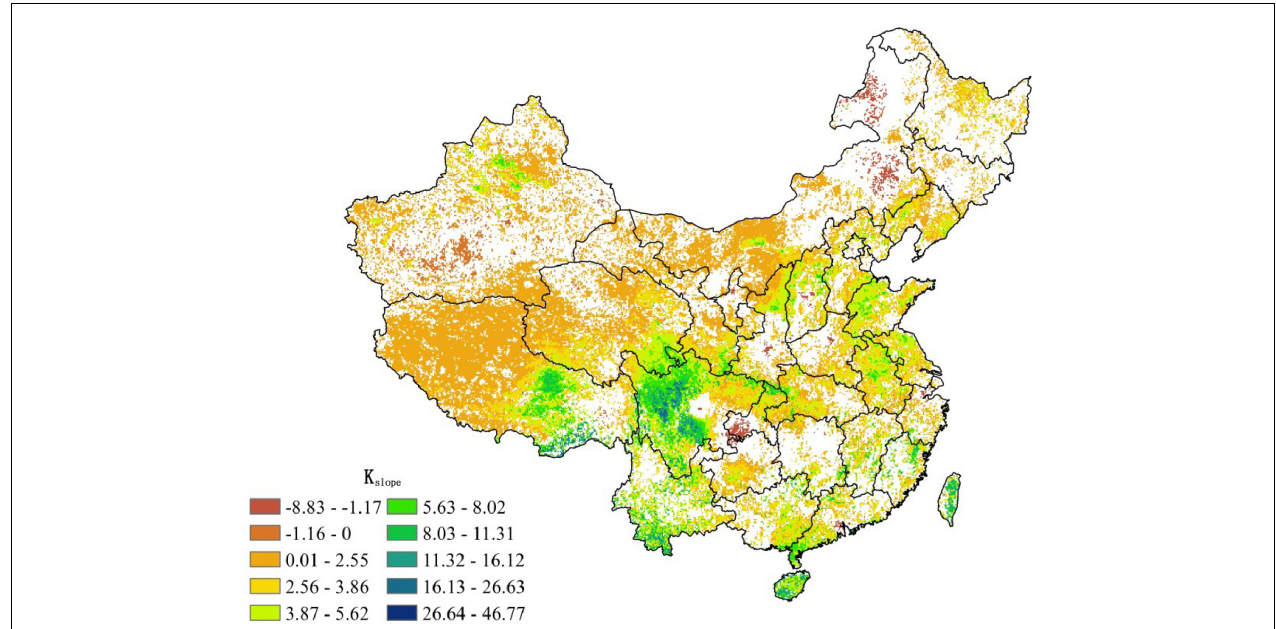
FIGURE 8 | The long-term trends of annual NPP in China from 1982 to 2012 ( P < 0.1 or 90% significance